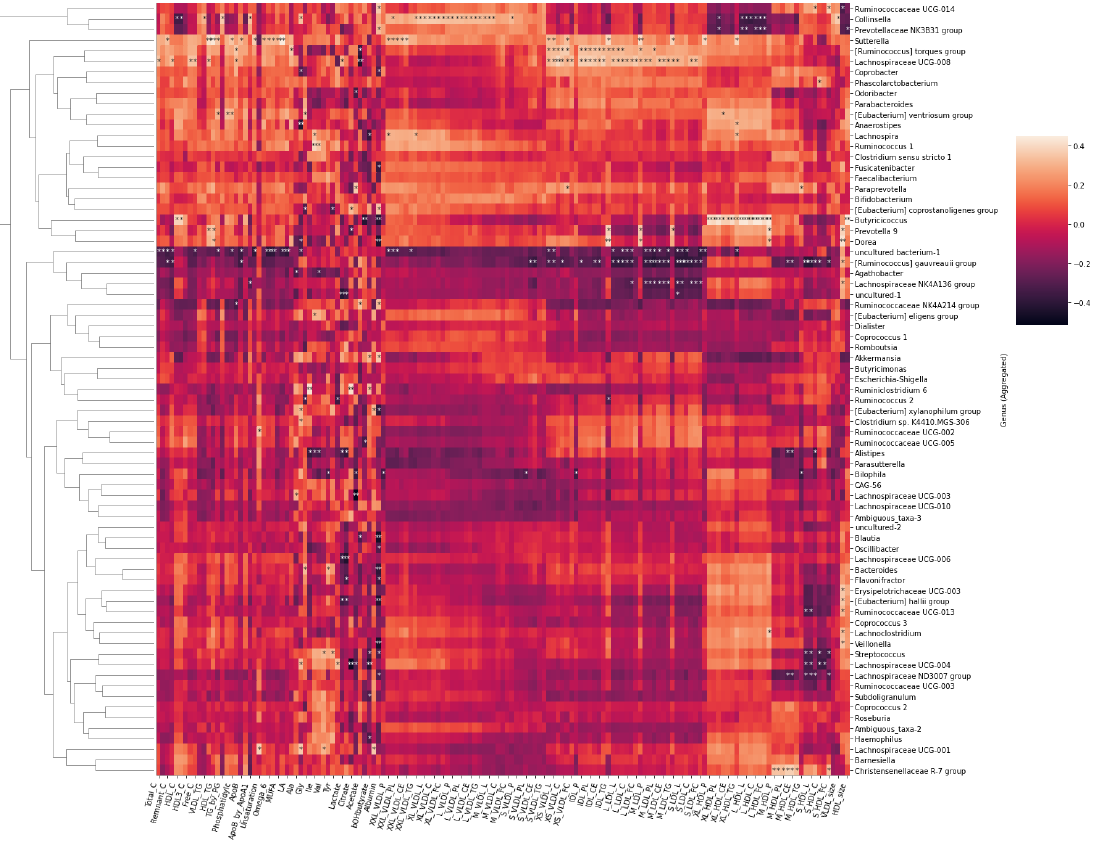
Figure 8. Heatmap of Spearman correlation coefficients between the serum metabolites and gut microbial genera. Spearman p value * < 0.05 ** < 0.01.